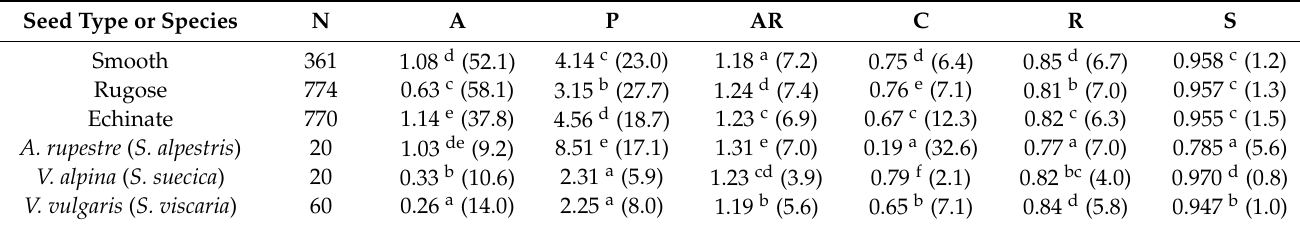
Table 3. Results of Kruskal–Wallis and post hoc tests for the lateral views of seeds in three groups of Silene species (smooth, rugose and echinate) and for species Atocion rupestre , Viscaria alpina and Viscaria vulgaris . Mean values and coefficients of variation (given in parentheses) are indicated for area (A), perimeter (P), aspect ratio (AR), circularity (C), roundness (R) and solidity (S). Values marked with the same superscript letter in each column correspond to populations that do not differ significantly at p < 0.05 (Campbell and Skillings’s test). N indicates the number of seeds analyzed.